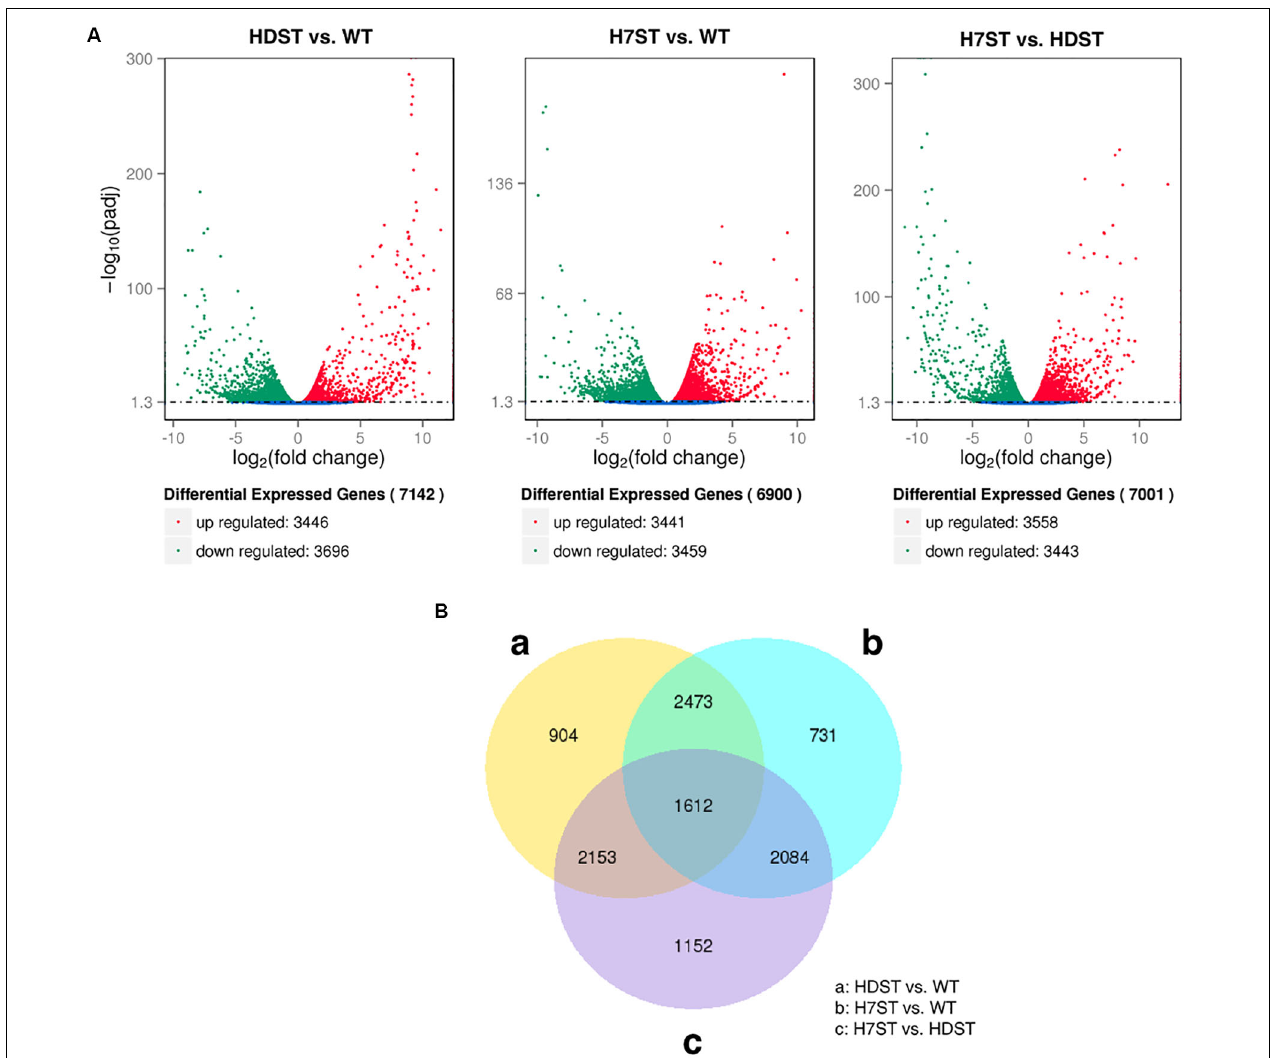
FIGURE 3 | Differentially expressed genes (DEGs) in three phenotypically diverse strains. (A) Volcano plot for DEGs. The x-axis indicates the gene expression fold-changes between different strains, whereas the y-axis indicates the significance of the differences. Significantly up- and down-regulated genes are highlighted in red and green, respectively. The blue dots indicate the genes that were not differentially expressed between strains. (B) Venn diagram of DEGs. The sum of the numbers in each circle represents the total number of expressed genes within a comparison, whereas the numbers in the overlapping areas represent the number of expressed genes shared between